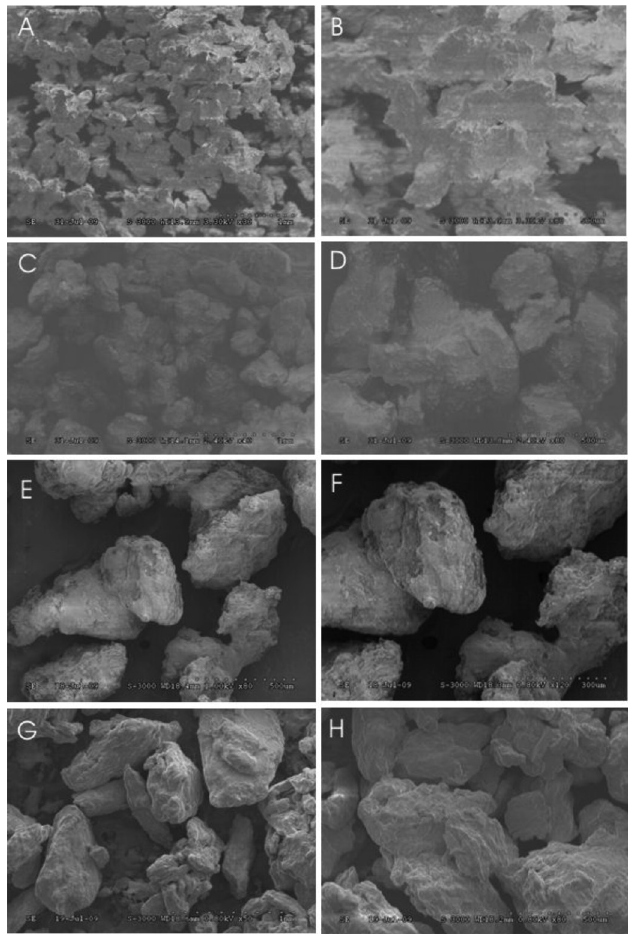
FIGURE 2 - SEM pictures of trial-1A (A) 30x and (B) 100x; trial-1B (C) 40x and (D) 80x; trial-2A (E) 80x and (F) 120x; trial-2B (G) 50x and (H)